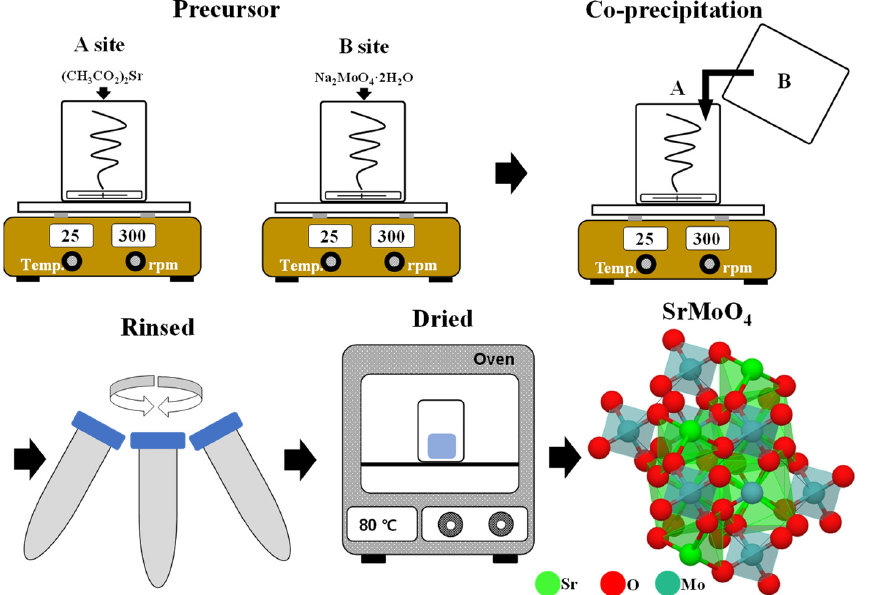
Figure 1. Schematic of experimental procedure.